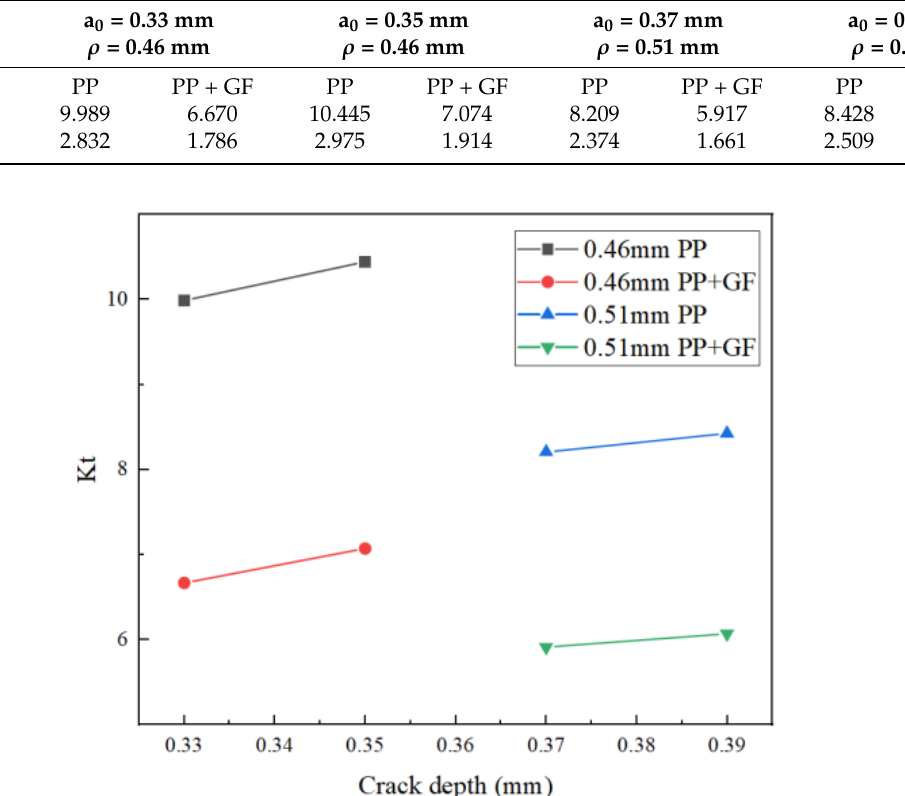
Figure 11. Theoretical stress concentration coefficient of PP materials (with glass fiber) and PP materials (no glass fiber).